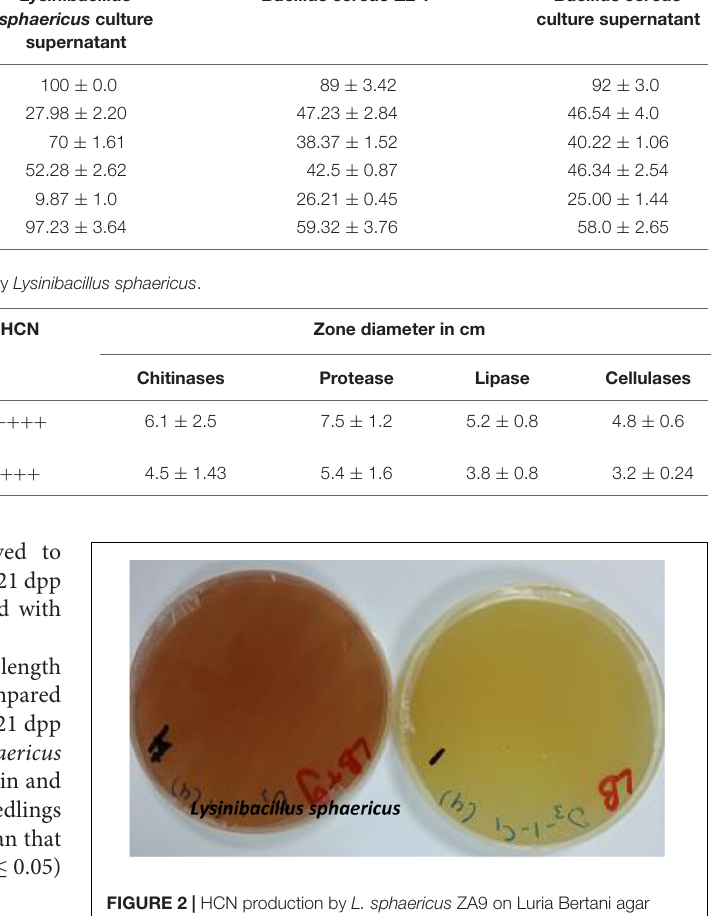
Extraction of Antifungal